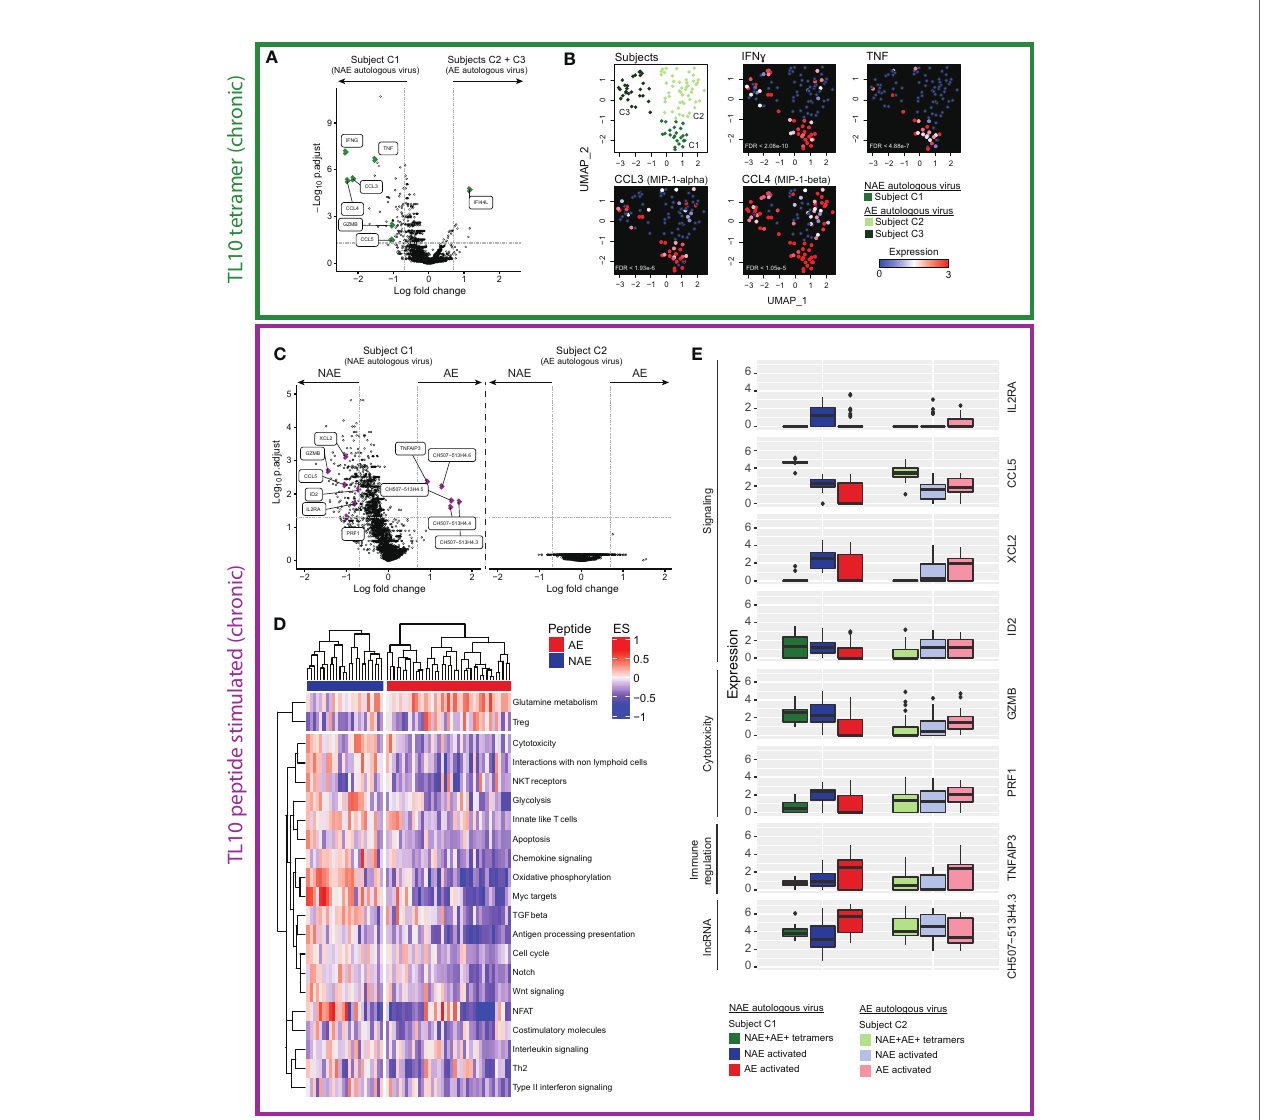
FIGURE 3 | Single cell transcriptome analysis of cross-reactive resting (dual tetramer + ) and activated (peptide stimulated) memory CD8 + T cells for the epitope TL10 reveals distinct pro fi les dependent on NAE/AE status of autologous HIV epitope. (A) Volcano plot of cross-reactive resting memory CD8 + T cells to the epitope TL10 demonstrates a number of signi fi cant DEGs across donors with different autologous viruses (N = 3). Key effector genes (pro-in fl ammatory, chemokine and cytotoxic) are highlighted in green. Horizontal and vertical dotted lines represent a signi fi cant threshold of a false discovery rate (FDR) of 0.05 and a fold change (natural log) of |2|, respectively. Note XIST (highest point) is highly expressed in subject C1 relative to the other subjects, as C1 is female while C2 and C3 are male. (B) UMAP representation of cross-reactive resting memory CD8 + T cells for subjects C1-3 with heatmap expression levels of signi fi cant DEGs suggestive of polyfunctional and cytotoxicity capacity from panel A (N = 3). (C) Volcano plots of cross-reactive activated memory CD8 + T cells in subject C1 showed signi fi cant DEGs after NAE and AE peptide stimulation, but no signi fi cant DEGs were observed for subject C2 (N = 2). Effector genes driving multiple biological pathways (in D) are highlighted in purple. (D) Pathway analysis of the transcriptome of the cross-reactive activated memory CD8 + T cells in subject C1 shows different pathways were upregulated depending on the form of the stimulating peptide (N = 1). Outcomes from hierarchical clustering are indicated. Only pathways that have a signi fi cant difference between stimulations (p<0.05) are depicted. Each column is one cell and horizontal bars indicate the stimulating peptide. (E) Box plots demonstrate the fold change in expression level of signi fi cant DEGs in multiple pathways in panel D in the cross-reactive resting (dual tetramer + ) and activated memory CD8 + T cells in subjects C1 and C2 (N =